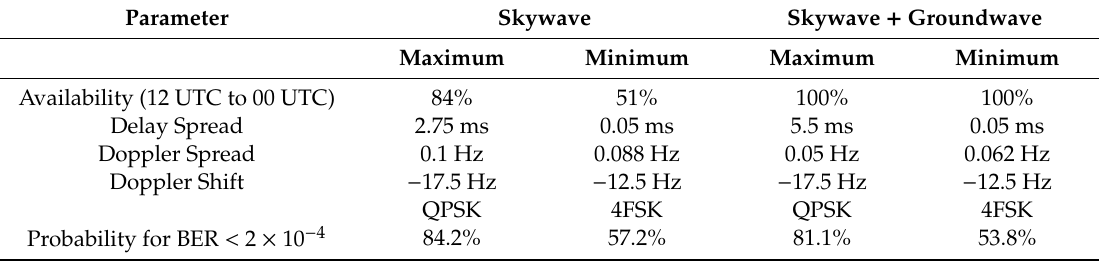
Table 1. Measured NVIS channel